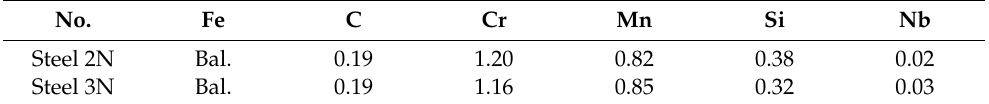
Table 1. Chemical composition of the experimental steels (wt %). No. Fe C Steel